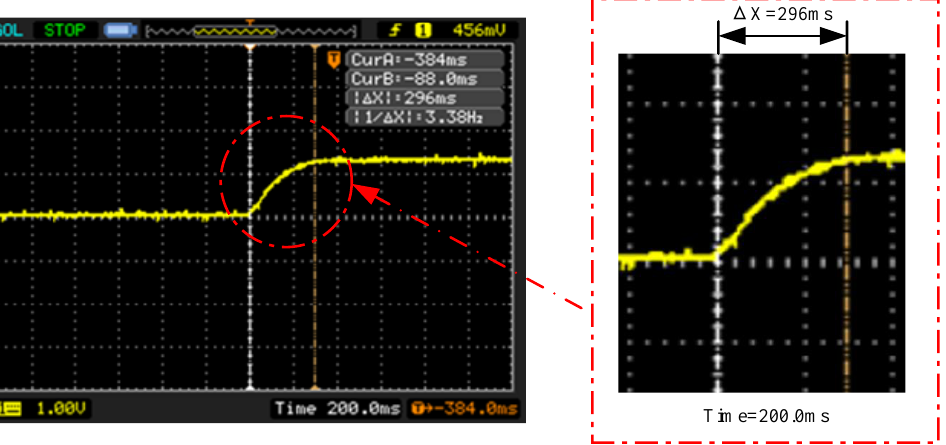
Figure 12. The dynamic characteristic curve of the output of the impedance measurement circuit.